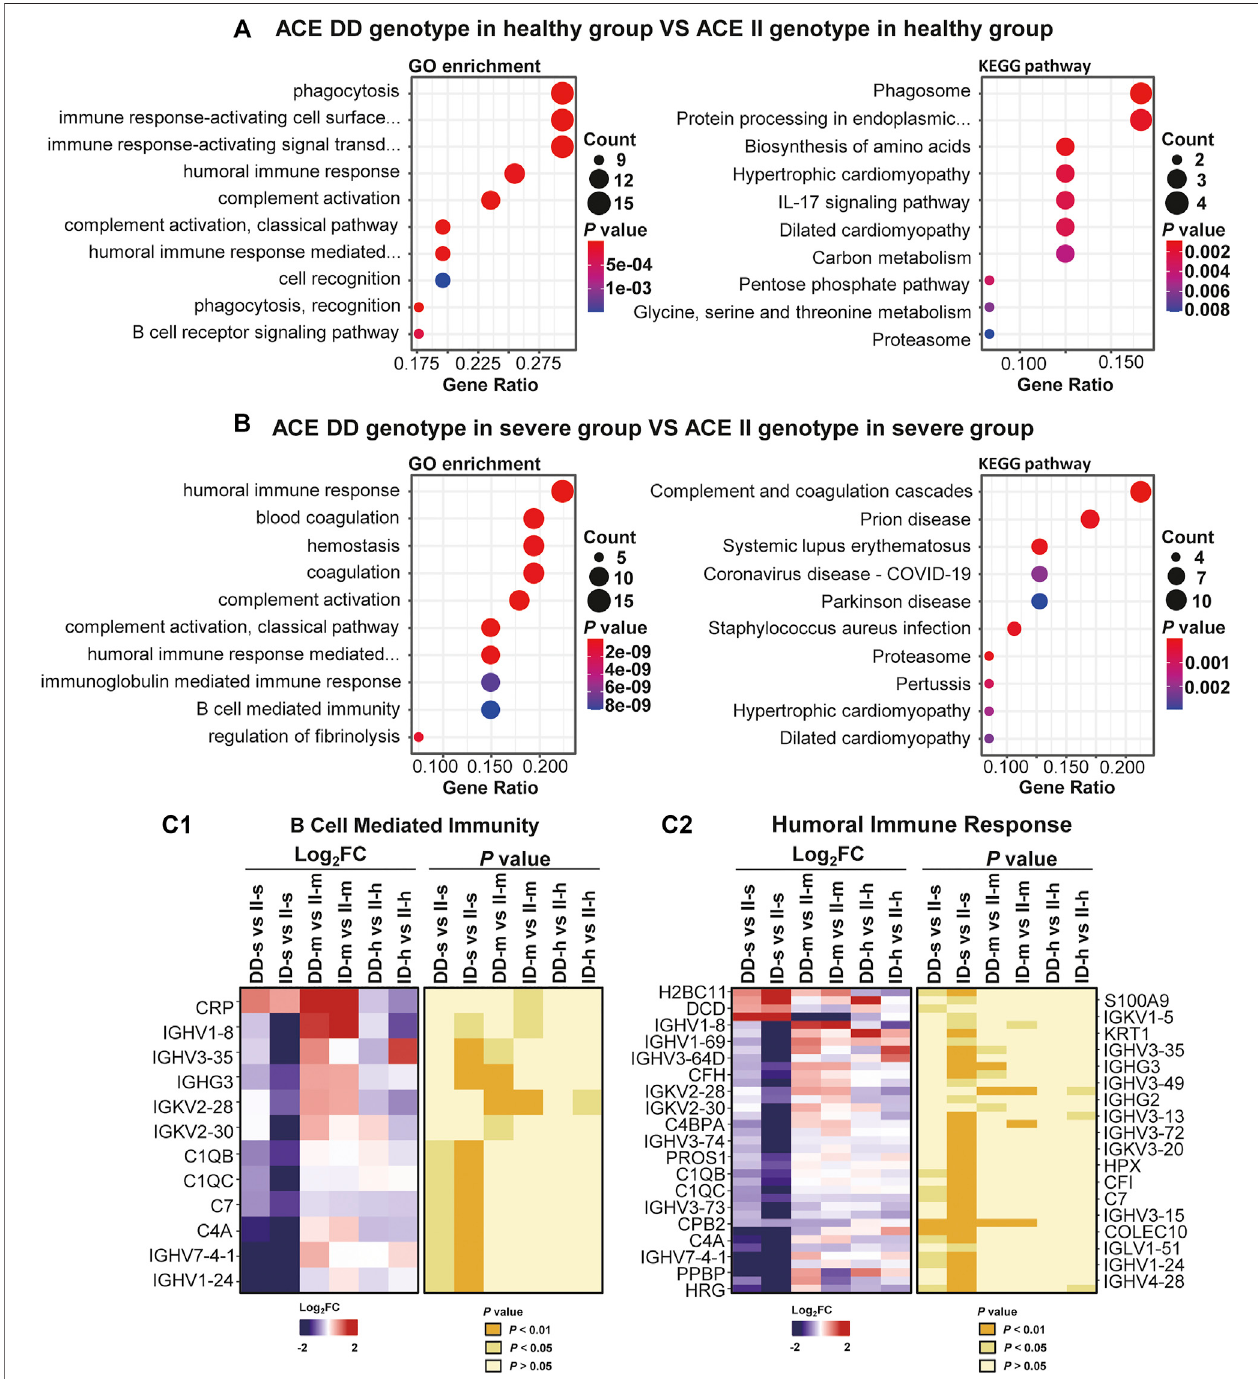
FIGURE 5 | Differential expressions in severe, mild, and healthy intragroups of prospective research. (A) The ACE DD genotype in the healthy group vs. ACE II genotype in the healthy group. (B) The ACE DD genotype in severe group vs. ACE II genotype in the severe group. GO enrichment analysis (left panel) and KEGG pathway analysis (right panel) of DEPs among DD, ID, and II genotype subgroups severe and healthy intragroups. GO analysis showed the top ten biological processes (BP) sorted by p value. KEGG analysis shows the top 10 pathways sorted by using the p value. (C1, C2) The expressions of proteins in the B-cell – mediated immunitybiologicalprocess andhumoralimmuneresponsepathway insevere,mild, andhealthyintragroups.Both (C1,C2) containedtwosets ofpanels. Theleft panel shows the protein intensity ratiobetween different groupsafter log 2 processing, withred indicatingincreased expression and blue indicatingdecreased expression. The p value of each ratio was calculated at the corresponding position in the right panel. Each protein in (C1, C2) has a fold change and a p -value, and just for better presentation, someareshownon theleft,and theothersareontheright. For (C1) ,atotalof12proteins areshown onlyontheleft, andfor (C2) ,atotalof37proteins are shown on the left and right of the fi